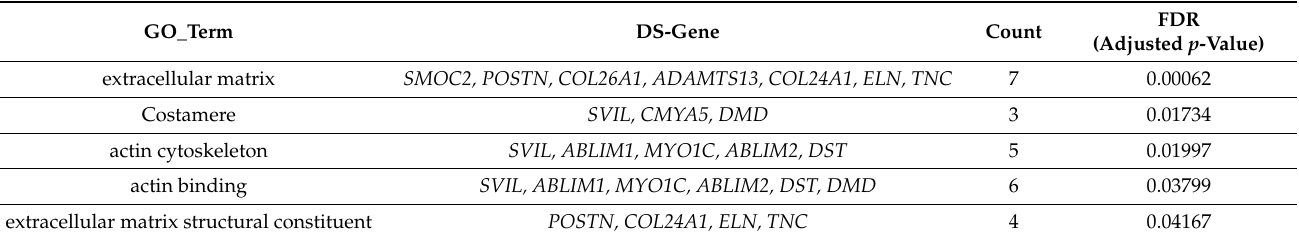
Table 4. GO analysis of differentially spliced